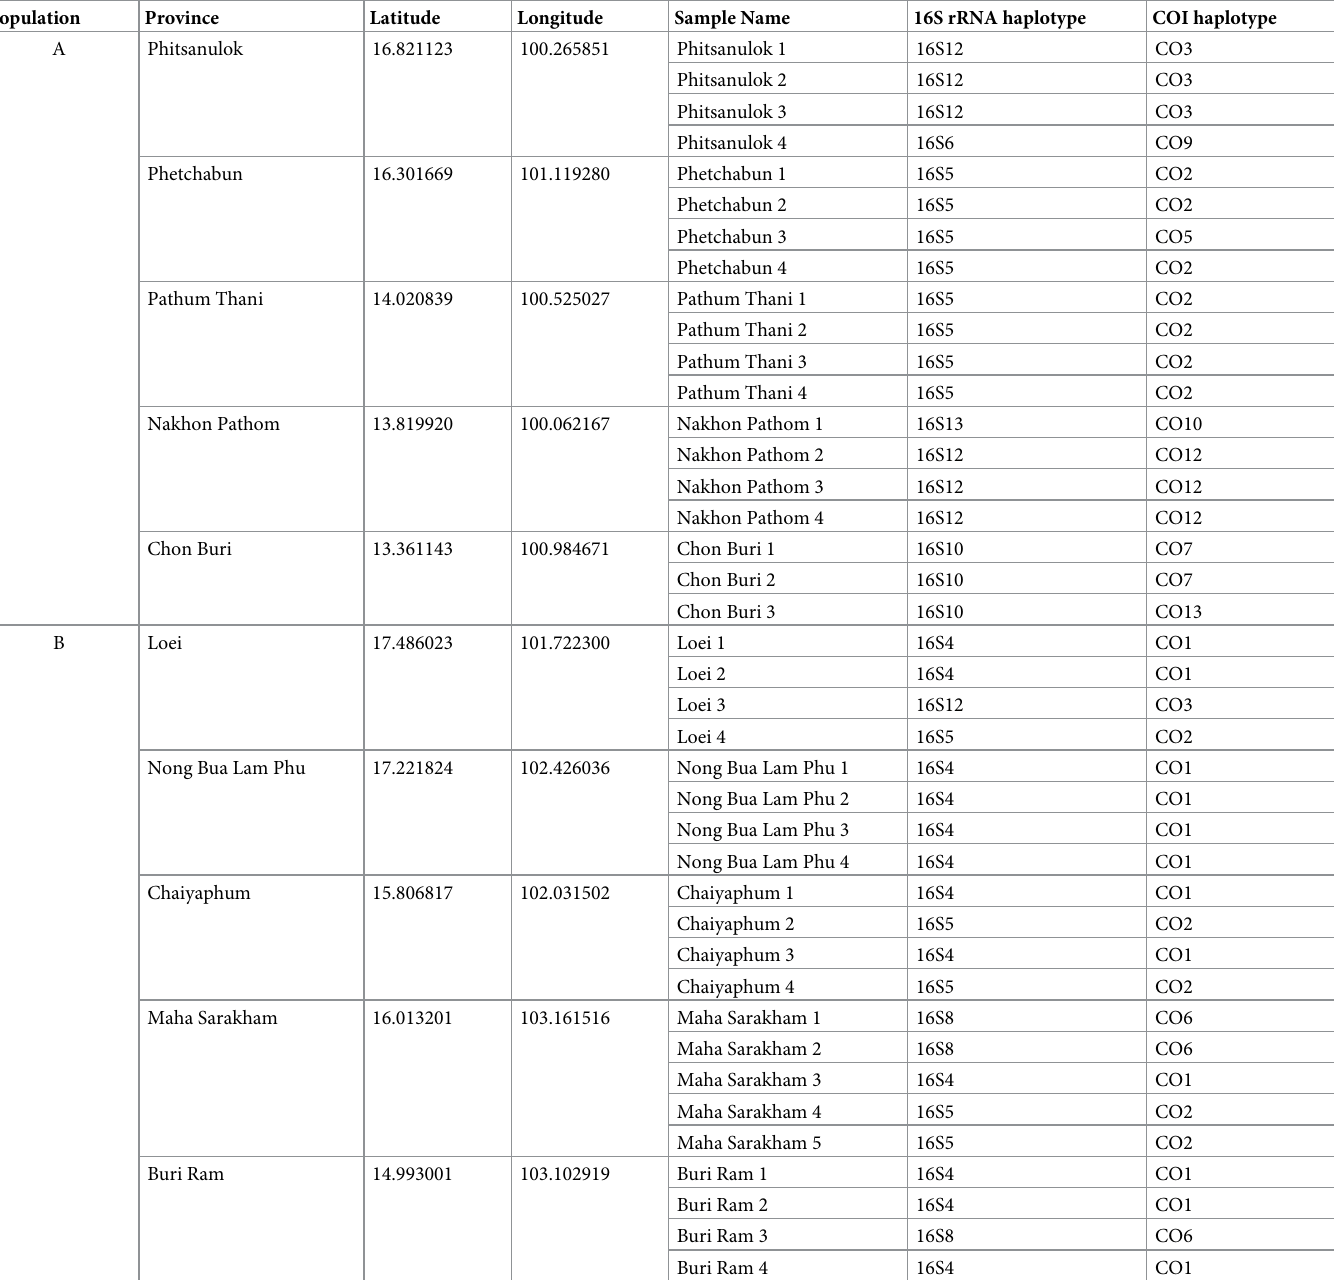
Table 1. Sampling locations of the Cryptozona siamensis collected from across Thailand, with the 14 haplotypes based on the 16S rRNA and COI sequences.